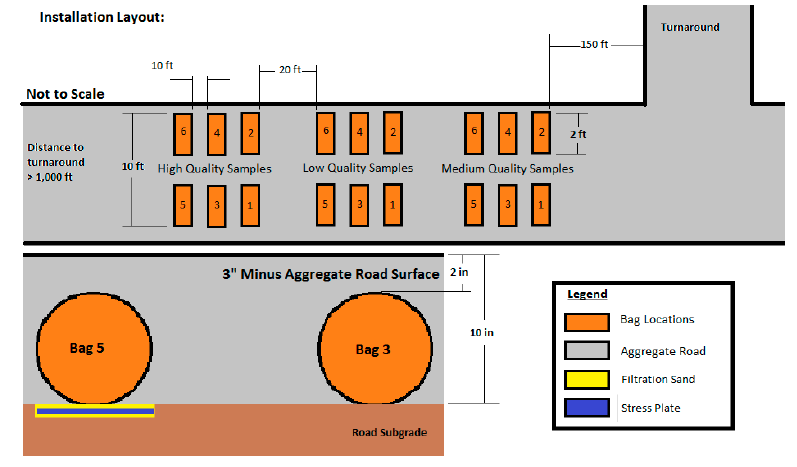
Figure 1. Field sample installation layout. 159